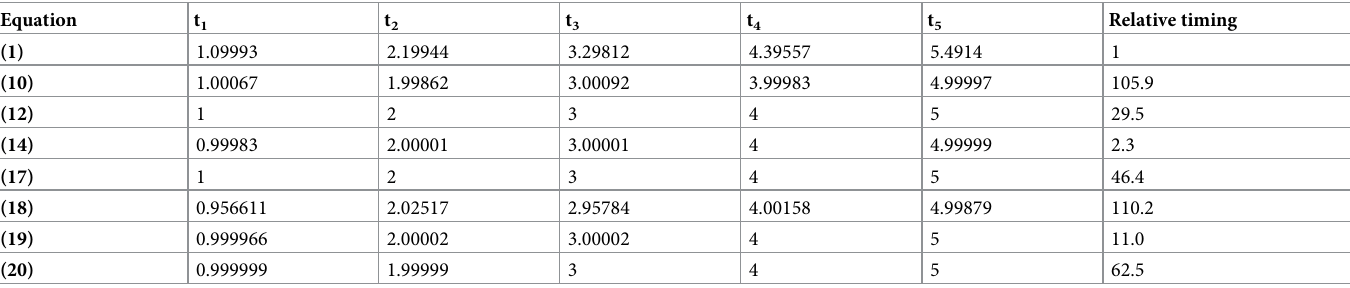
Table 1. Comparison of the fit results for different error sums. The first column refers to the equation of the corresponding error sum used for the fit (cf. section Deri-